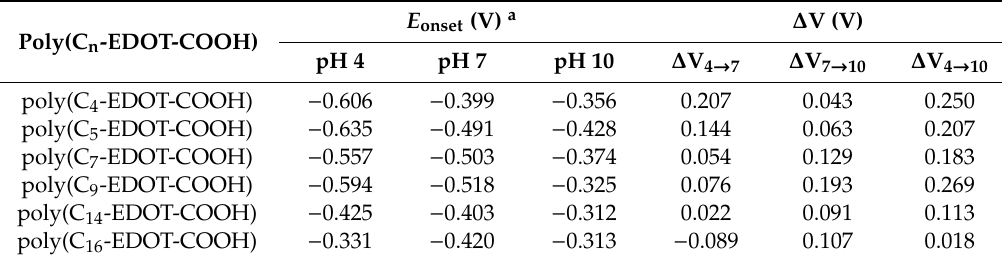
Table 1. E onset and Δ V of poly(C n -EDOT-COOH)s at different pH. Poly(C n